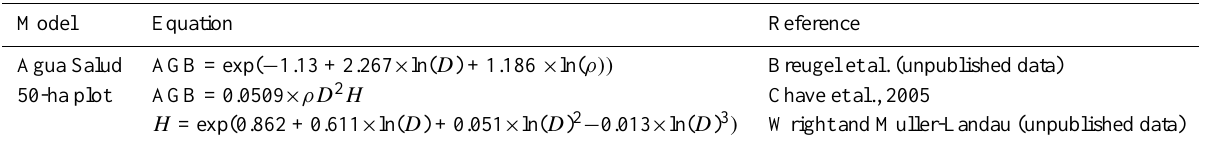
Table 1. Allometric equations used to estimate aboveground biomass in field inventory plots. AGB = dry aboveground biomass (kg), D = diameter (cm), H = height (m), ρ = wood specific gravity (i.e., wood density; gcm − 3 ) . Carbon content was estimated as 48% of AGB (IPCC 2006).